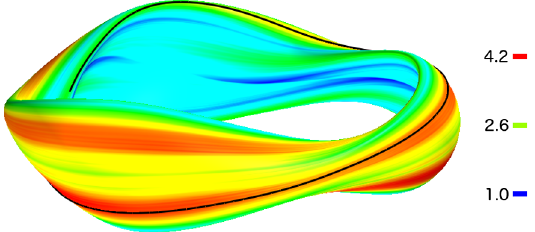
FIG. 1. Root-mean-squared normalized density fluctuations ¼ 2 Þ on the magnetic surface caused by ITG turbulence ð 1 =L T i of the QUASAR stellarator in the small- ρ (cid:3) regime. The strongest fluctuations appear localized around the magnetic field line with α ¼ π = 3 (black), and similarly for the line with α ¼ − π = 3 (not shown), because of the symmetry of the configuration. The number of grid points in the five-dimensional phase space ð x; y; z; v ; μ Þ is 128 × 128 × 128 × 64 × 10 . The simulation box ∥ size for the radial direction is L x ¼ 147 ρ and for the binormal direction L y ¼ 204 ρ . Also, L z ¼ 2 π for the parallel direction (parametrized by the poloidal angle). The simulation box size for the parallel velocity is − 3 v t ≤ v ∥ ≤ 3 v t and for the magnetic ffiffiffiffiffiffiffiffiffiffiffiffiffiffiffi p 2 T =m is the thermal moment 0 ≤ μ ≤ 9 T i =B 0 . Here, v t ¼ i i =a 2 . velocity and B 0 ¼ 2 Φ lcfs